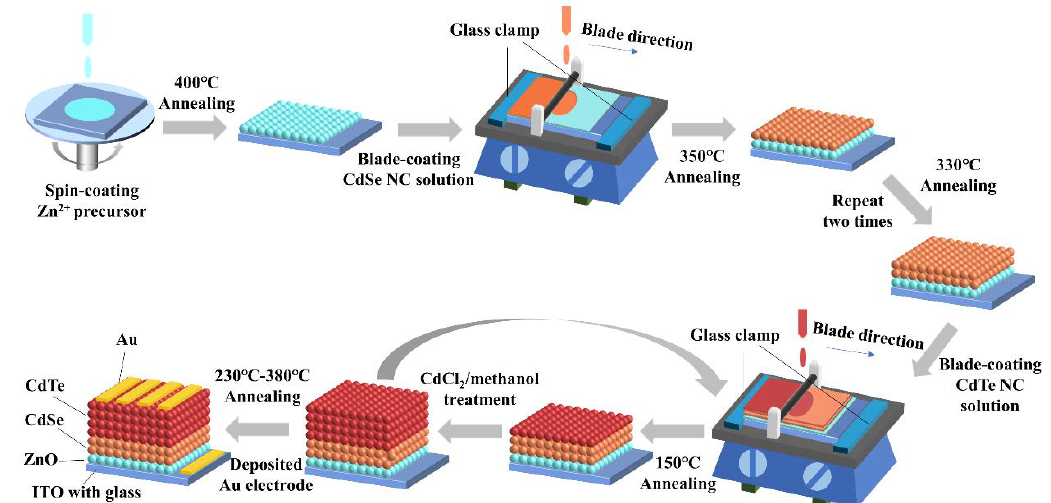
Figure 1. A schematic of the nanocrystal (NC) solar cells fabricated via blade coating.